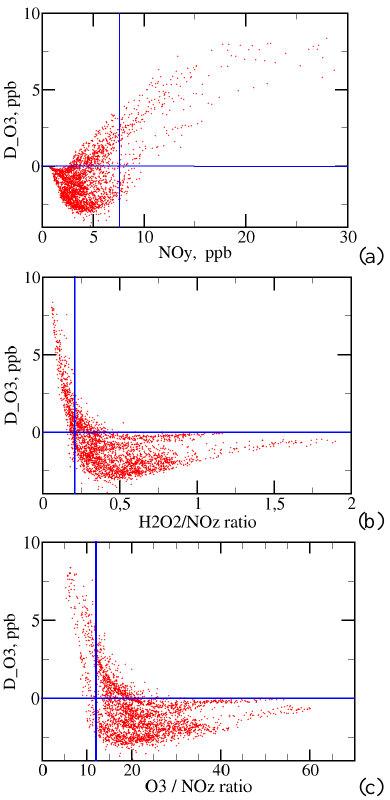
Fig. 4. Relations between chemical regimes and indicators, aver- aged over summer (May–August) 2001 at 15:00UT, as in Table 2. Each point in the scatter plot corresponds to values for individual grid